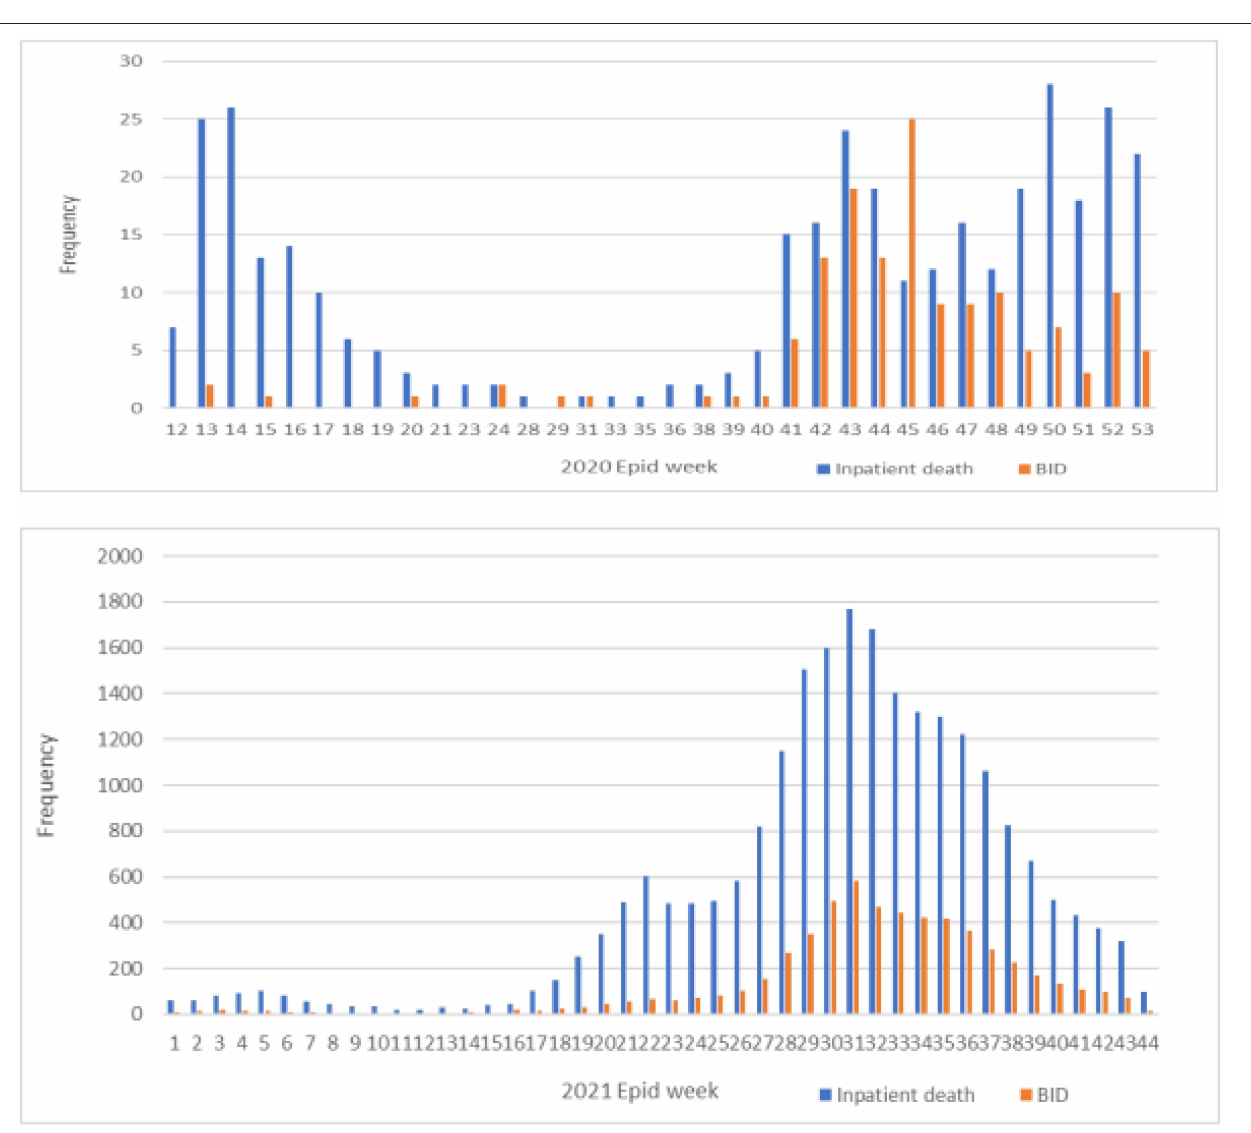
FIGURE 1 | Distribution of inpatient death and the brought-in-dead (BID) COVID-19 mortality cases between the years 2020 and 2021.